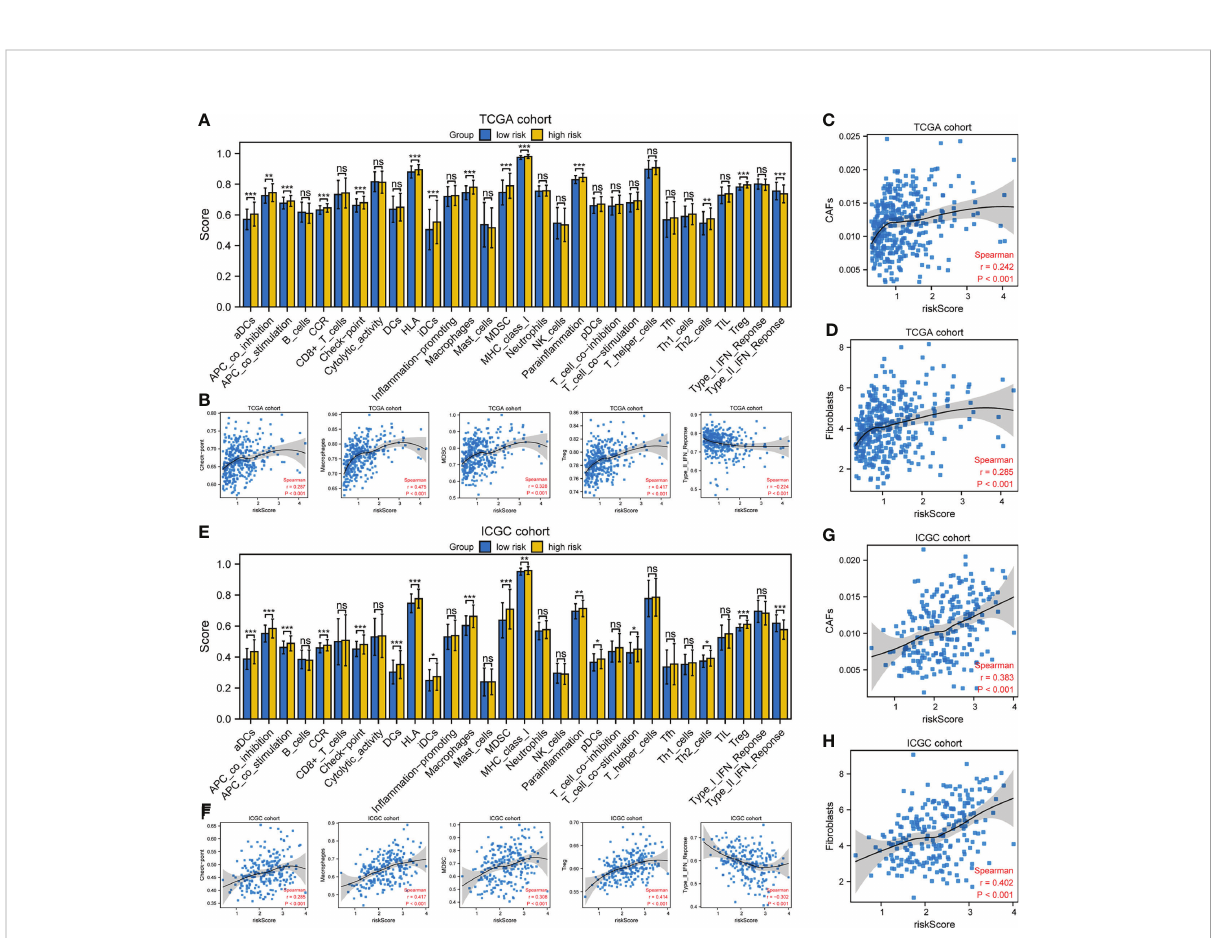
FIGURE 7 Tumor immune microenvironment analysis. (A, E) ssGSEA scores of 17 immune cells and 13 immune-related functions. ns: not signi fi cant; *P< 0.05; **P< 0.01; ***P< 0.001. (B, F) Spearman ’ s rank correlation analysis between risk score and immune checkpoints, macrophages, MDSCs, Tregs, and type II IFN response. (C, D, G, H) Spearman ’ s rank correlation analysis between risk score and CAFs according to the (C, G) EPIC and (D, H) MCPcounter algorithms. (A – D) TCGA cohort; (E – H) ICGC